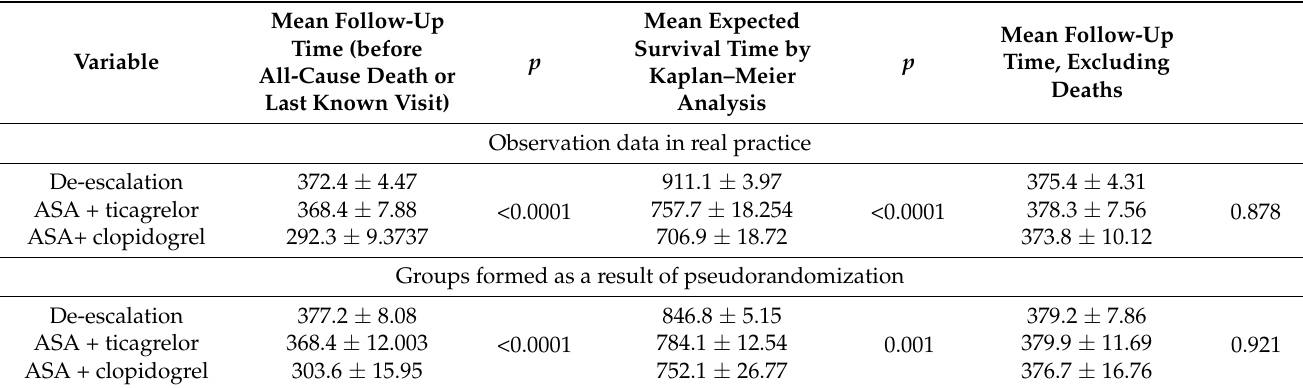
Table 4. The time before all-cause death at different regimens of APT (Kaplan–Meier